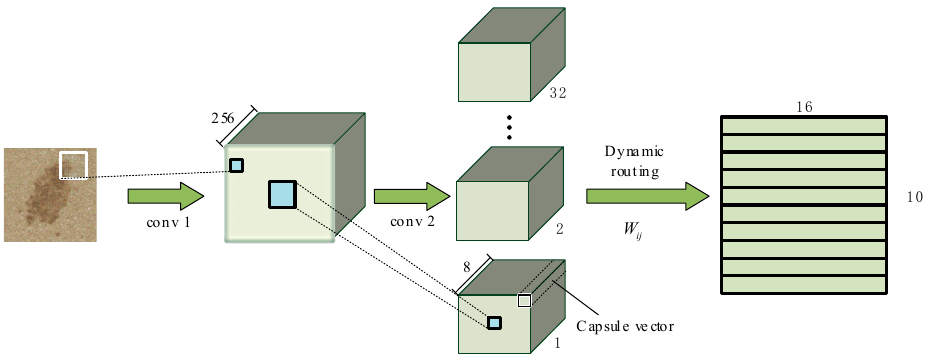
Figure 1. The main structure diagram of the Capsule Network.